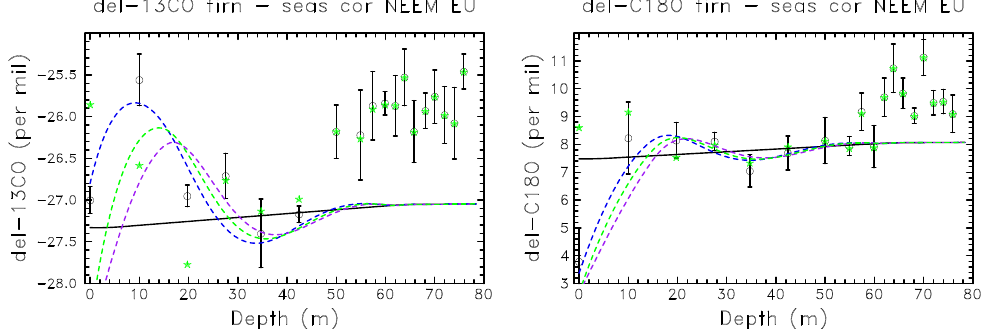
Fig. 2. Effect of atmospheric seasonality on δ 13 C (left) and δ 18 O (right) of CO in NEEM firn. Measured isotopic ratios are shown as black Fig. 2. 797 circles with error bars, and green stars show δ 13 C and δ 18 O values corrected from the effect of seasonality. Simulated values with de- seasonalized atmospheric scenarios are plotted as black lines; simulated values with atmospheric seasonal cycles are plotted as green dashed lines. The differences between uncorrected (black circles) and corrected (green stars) firn data are the same as the differences between simulated values without (black lines) and with (green lines) seasonality. The increasing isotopic ratios with depth obtained from constant scenarios (black lines) illustrate the effect of gravitational fractionation. The purple and blue dashed lines show the effect of shifting the final date of the simulation (firn drilling date) by plus or minus 15 days, respectively. They are intended to illustrate the effect of atmospheric variations at a sub-monthly time scale.